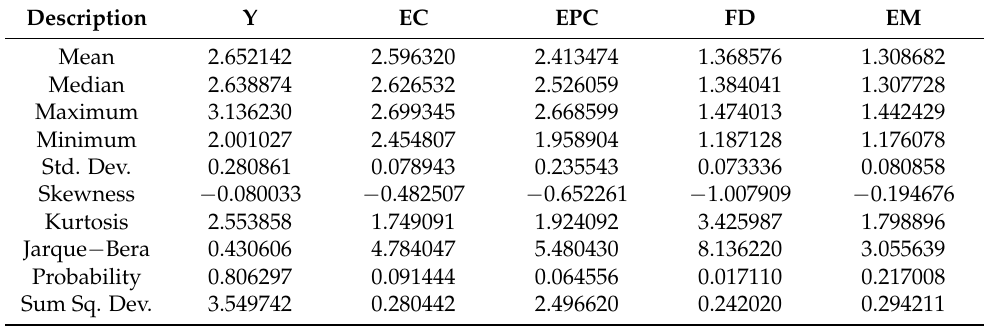
Table 1. Descriptive statistics of the